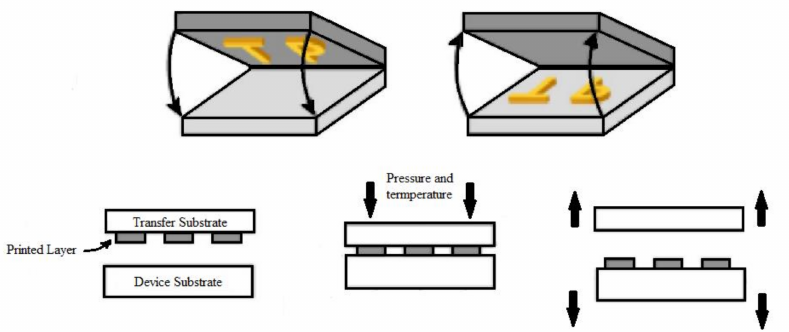
Figure 1. Schematic of the thermal transfer